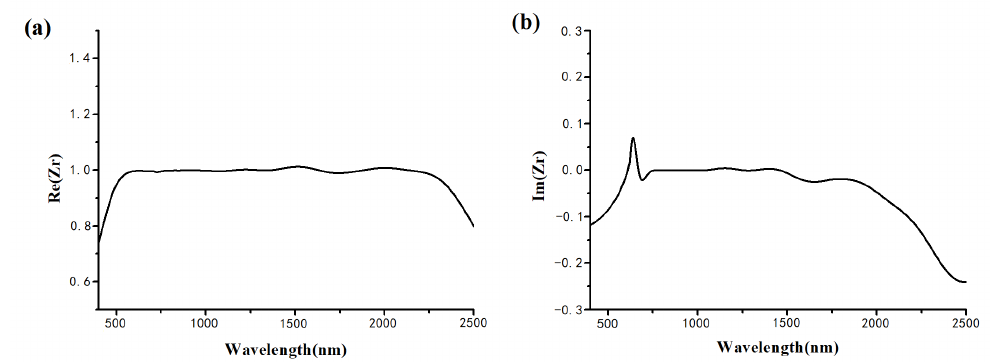
Figure 9. The real part ( a ) and imaginary part ( b ) of normalized complex impedance Z r of the absorber.